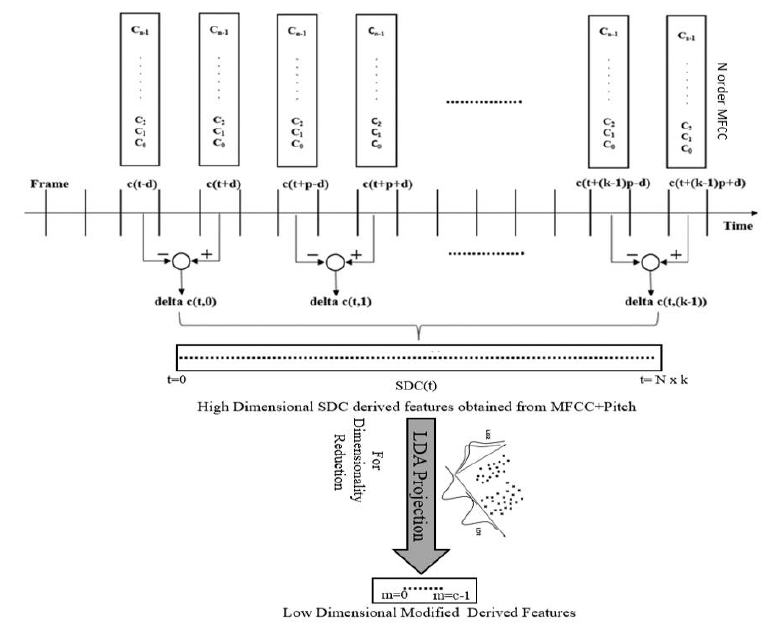
Figure 3. Proposed S-LDA